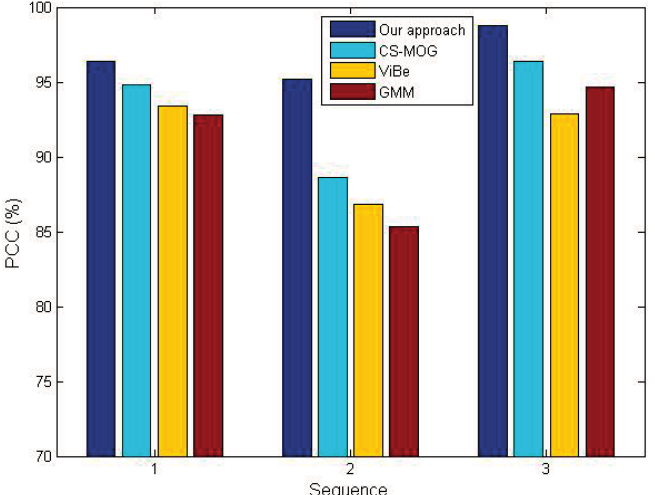
Figure 11. PCCs of four